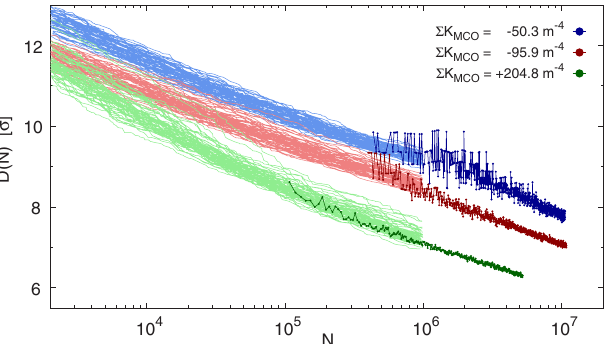
FIG. 6. DA estimates from simulations (lines) and measure- ments (lines with full markers) for three selected cases. The excellent agreement is visible, even if some difference in slope between measured and simulation results is visible for the case Σ K ¼ − 50 . 3 m − 4 . The DA is not given in units of beam σ , MCO but rather in units of the nominal σ obtained with the nominal ¼ 3 . 75 μ beam emittance of ϵ n